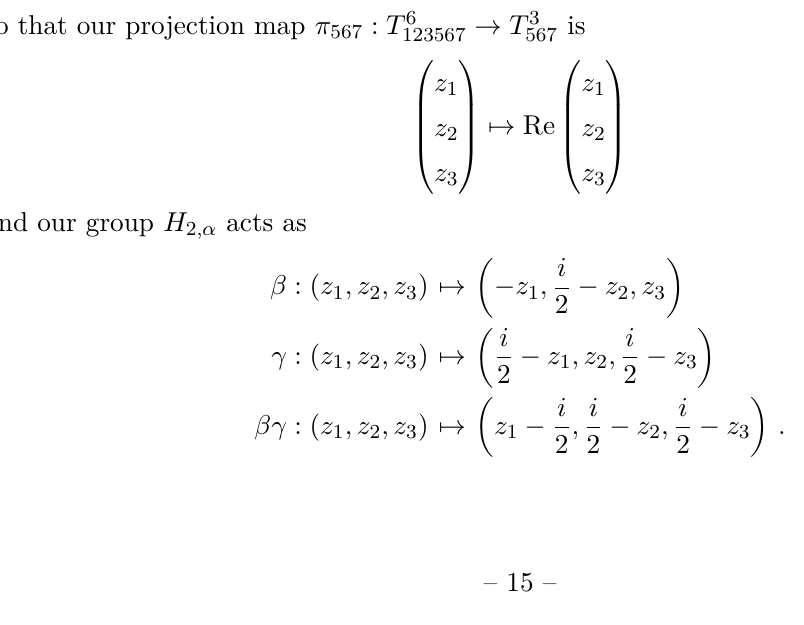
Figure 3 . A schematic view of the half- G 2 limit of the G 2 orbifold X 2 from example 3.2 with the α -fibration. We have stretched X 2 along the direction of x 4 , the throat coordinate. The heterotic (cid:0) 1 (cid:1) , and is shown with its SYZ fibration of dual geometry Y is the inverse image π − 1 T 3 fibers 2 ,α 4 4 (black lines) over the 3-orbifold base Q (blue disk). Some of the black lines are singular fibers 2 ,α that do not create singularities in the total space; the singularities in the total space are displayed by red lines. The α -fixed loci (vertical red lines) are confined to the ends of the x interval, while 4 the β -fixed loci L and γ -fixed loci L stretch across the interval. These T 3 loci that stretch β 2 γ 2 across the interval intersect Y in a 2-component locus T 2 t T 2 . The monodromy action of α on 2 ,α the singular T 2 of Y fixed by β is to travel around a loop in x that begins at x = 1 , passes 2 ,α 4 4 4 through x = 0 or x = 1 , and returns to x = 1 along the other leg of L , so that the singular 4 4 4 β 2 4 T 2 ’s are swapped in